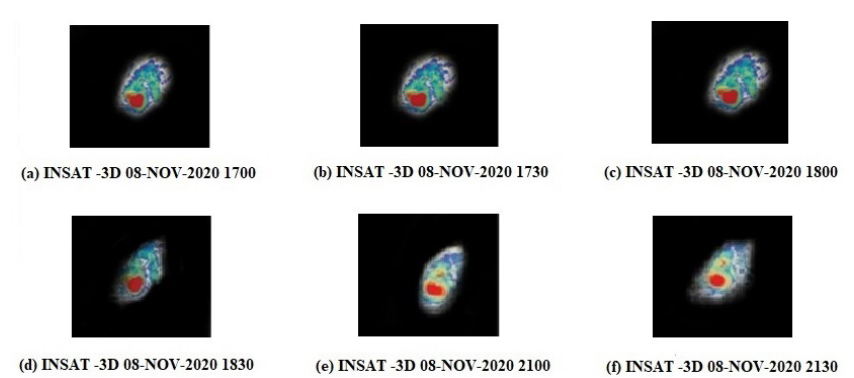
Fig. 3 Proposed sequential model using ReLU.